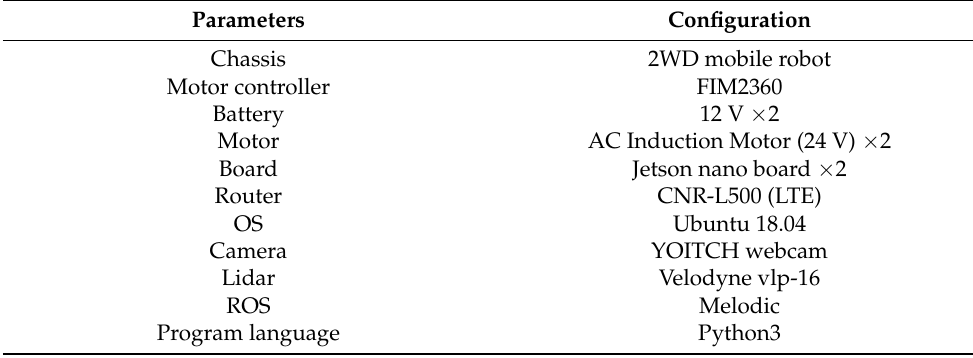
Table 2. Hardware and software specification of the mobile robot